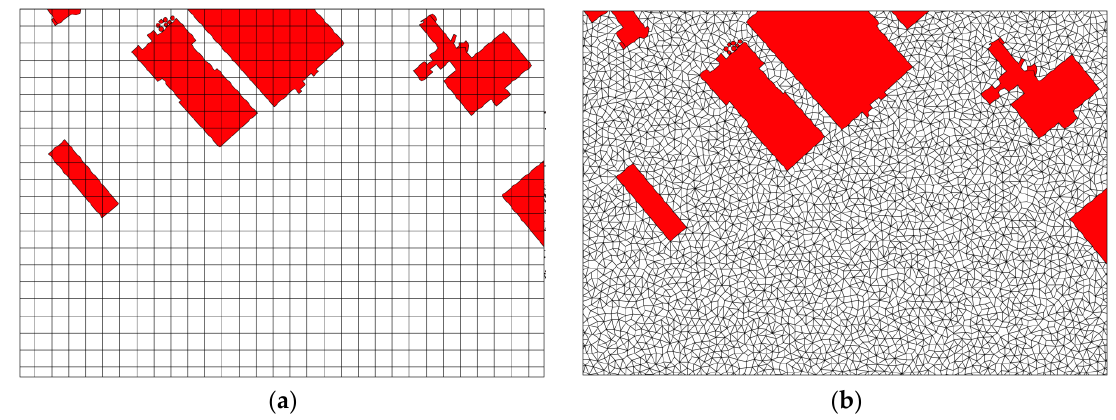
Figure 4. Example of flood data presented as a raster ( a ) or as unstructured, irregular meshes ( b ).